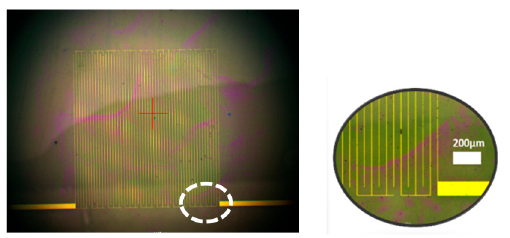
Figure 2. The sensor micrograph.